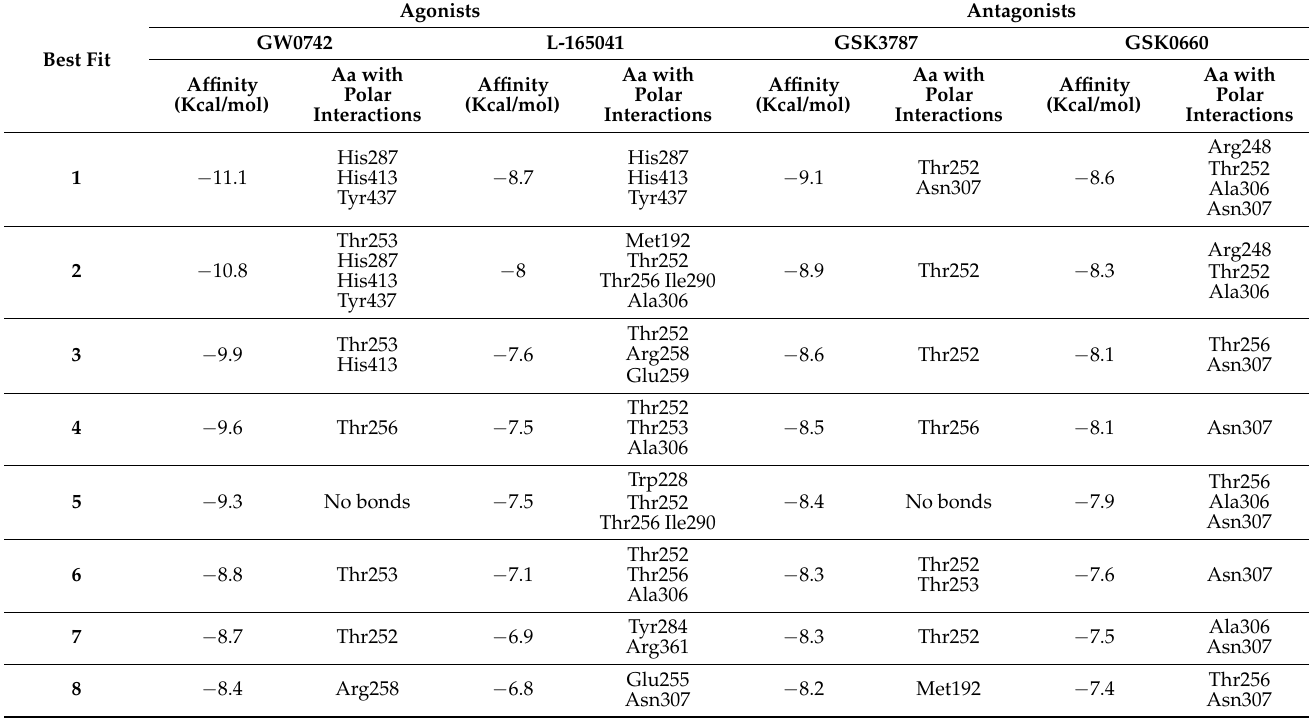
Table 1. Best eight docking hits of four ligands into PPAR β / δ (PBD: